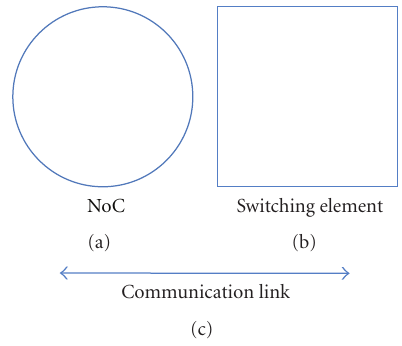
Figure 3: PNN as Interconnect-on-Chip.